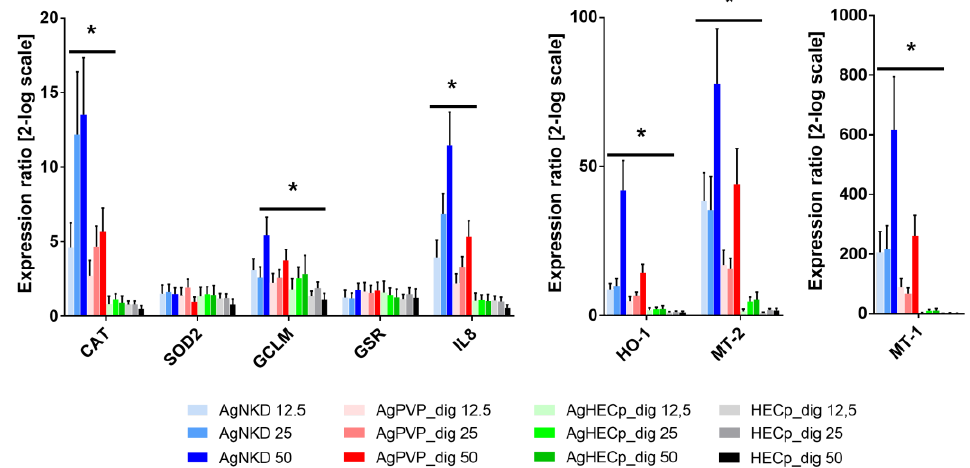
Figure 5. The mRNA expression analysis of HCT116 cells exposed to digested Ag NMs. RT-qPCR analysis was performed in cells exposed to 12.5, 25 or 50 µg/mL of digested AgNKD, AgPVP, AgHECp or HECp, focusing on oxidative stress markers (CAT, SOD2, GCLM, GSR, HO-1), inflammation (IL-8) and metal homeostasis (MT-1 and MT-2). Statistical significance, exposed vs. control, (*) p < 0.05.